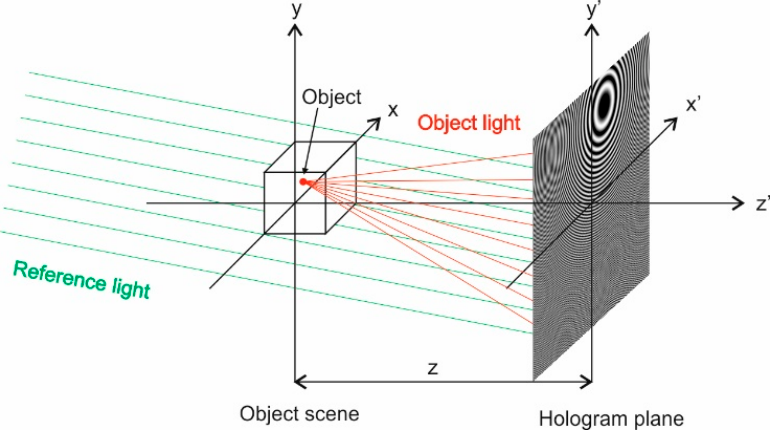
Figure 3. The construction of holographic feature maps using Computer-Generated Holography.